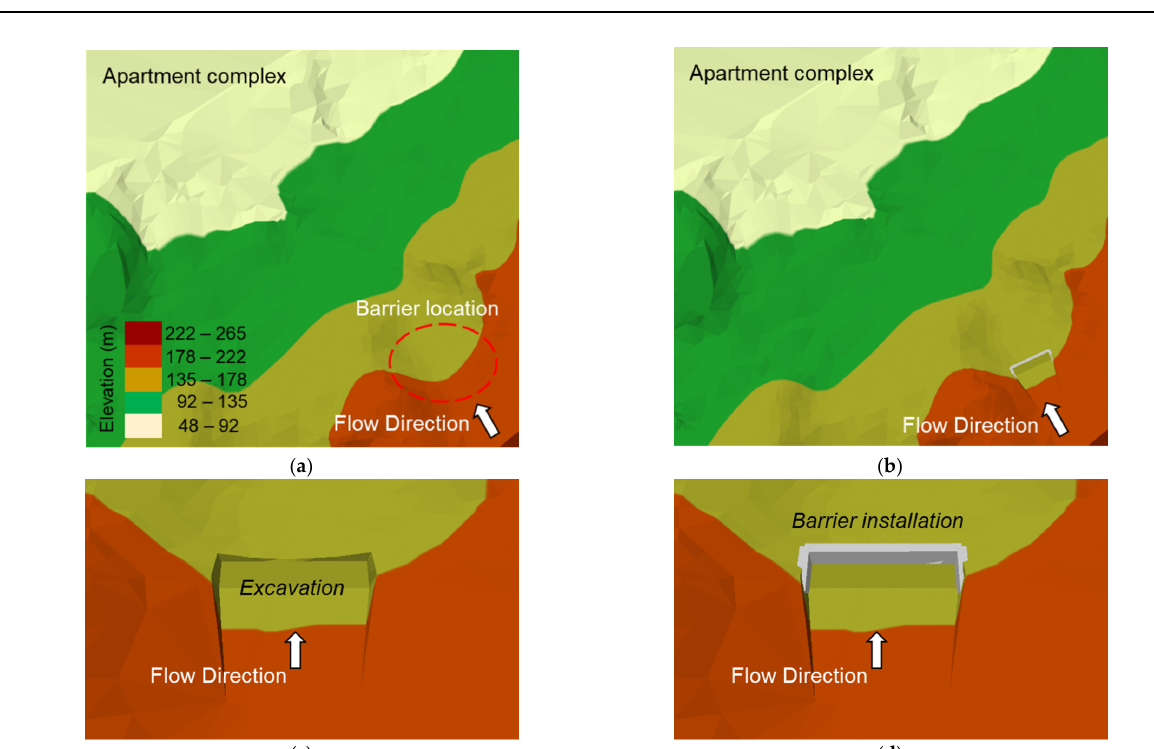
Figure 2. Schematics of an installed barrier: ( a , c ) the elevation model before barrier installation; ( b , d ) the elevation model after barrier installation.